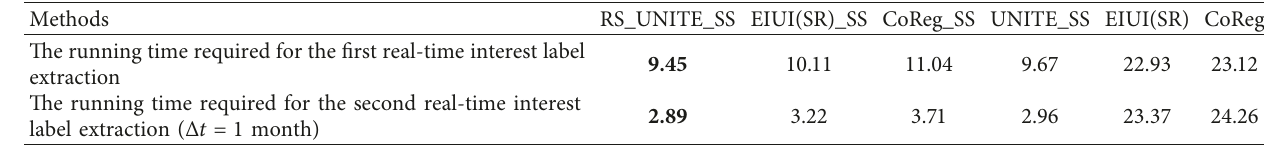
Table 8: CRunning time ( h ) comparison of user interest label extraction methods on SubGraphData. Table 9: Running time ( h ) comparison of user interest label extraction methods on WeiboData. Methods